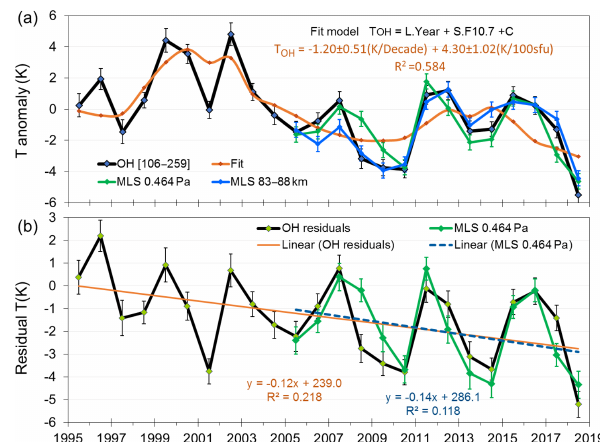
Figure 2. Superposed nightly mean temperatures from 1995 to 2018 (grey points) and a 5d running mean which represents the clima- tological mean (orange line) with 1 σ intervals (black lines). The seasonal variation (annual, semi-annual, terannual fit; green line) and mid-April and mid-August dips (red arrows) are also indicated. Green vertical lines mark the calculation region for winter mean temperatures (avoiding spring and autumn transition intervals). The NRL-MSISE00 reference atmosphere (local midnight values for Davis) is also added for comparison (gold points).